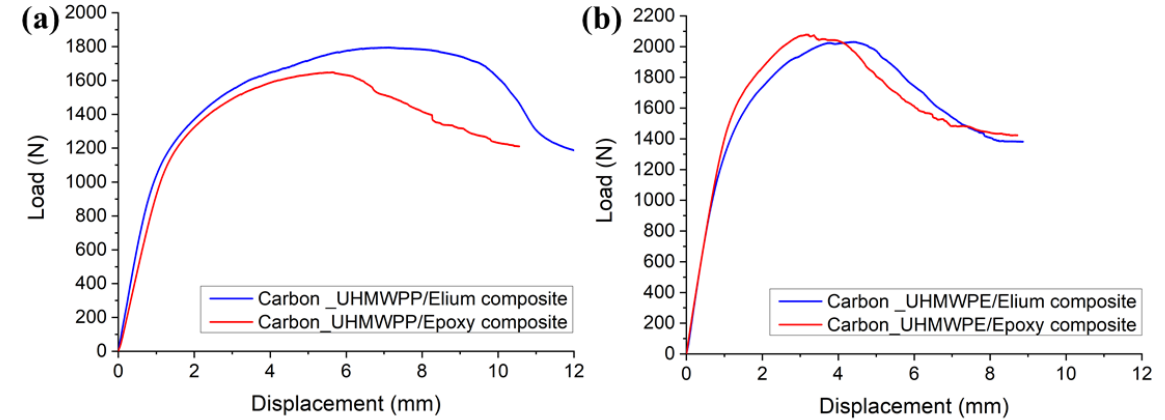
Figure 15 . Load vs. Displacement graphs for ( a ) Carbon_UHMWPP ( b ) Carbon_UHMWPE fiber reinforced composite configurations .